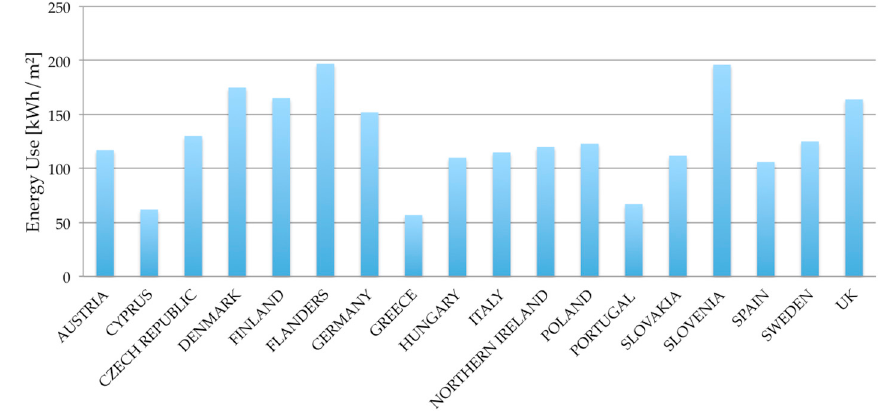
Figure 1. Energy uses of school buildings in European countries (varying from about 52 to 197 kWh/m 2 year) (elaboration of the authors from [8]).